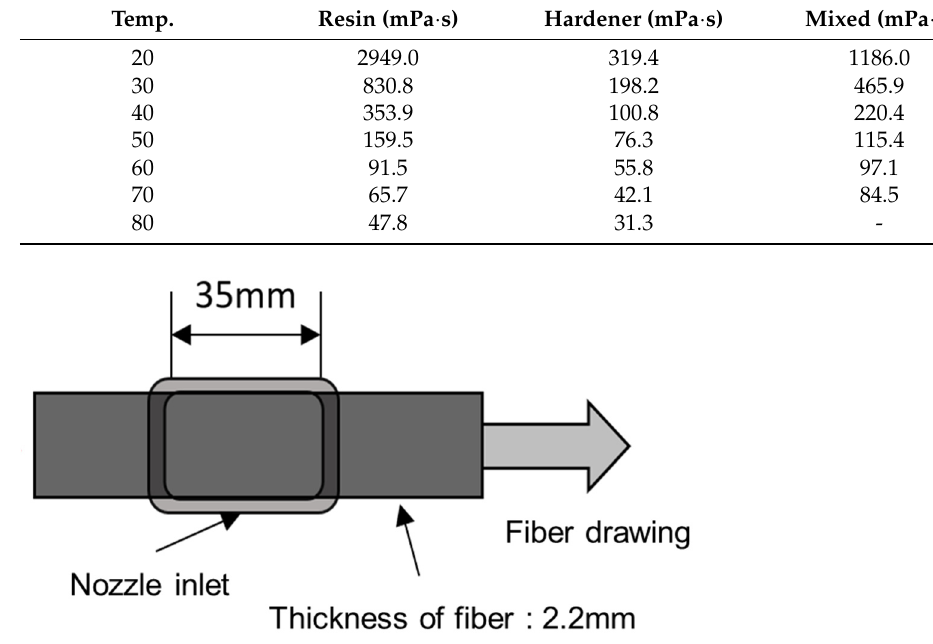
Figure 5. Resin injection part of the impregnation system. Table 1. Viscosity change of resin, hardener, and mixed resin at different temperatures. Temp.